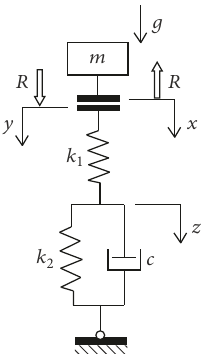
Figure 1: Visualization of viscoelastic system.